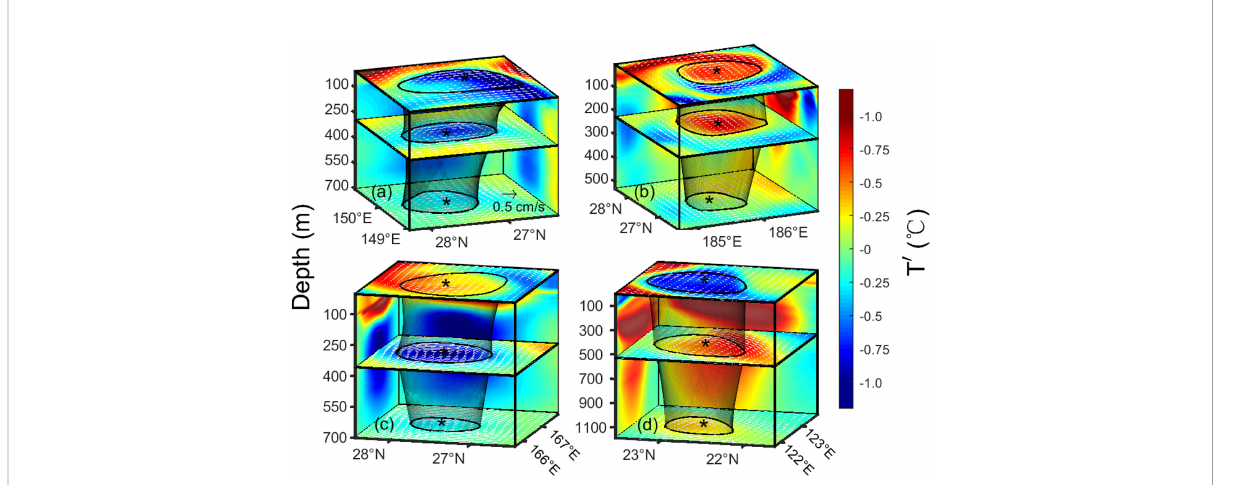
FIGURE 2 Three-dimensional structures of four types of eddy cases in the STCC region. (A – D) represent cyclonic cold-core eddy, anticyclonic warm-core eddy, cyclonic warm-core eddy, and anticyclonic cold-core eddy, respectively. The color and white vectors indicate the temperature anomaly (units: °C) and the velocity anomaly vector (units: cm/s) after high-pass space fi ltering. The black curves and the asterisk represent the eddy boundary and eddy center at the corresponding depth, respectively. The gray shadow represents the outer boundary of the eddy case. The vertical planes show the cross-section along the meridional and zonal directions through the eddy